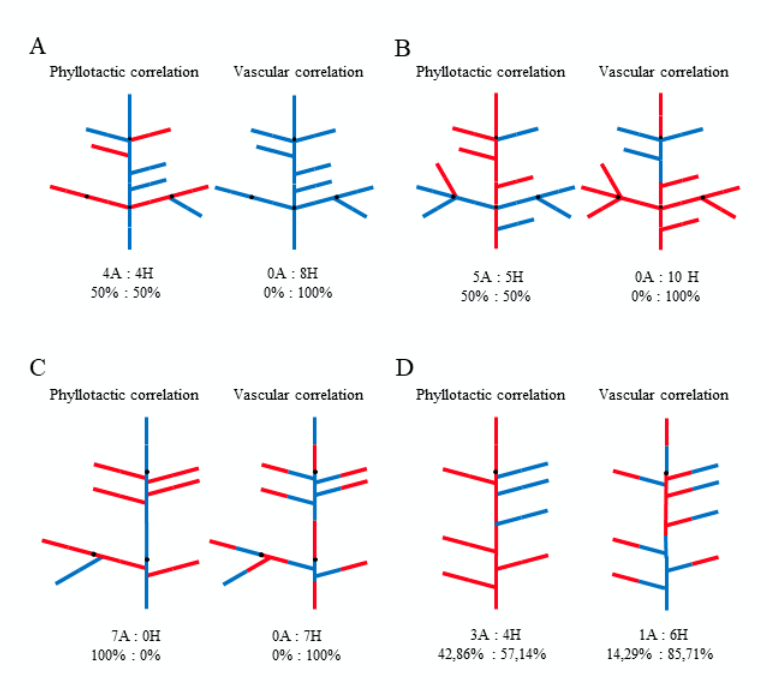
Figure 4 Paired schemes of phyllotactic and vascular correlations in the same branching shoot of Picea abies ( A ), Abies alba ( B ), and Cedrus libani subsp. atlantica ( C,D ). The orientation of ontogenetic helix (the chirality of phyllotaxis) and vascular parastichies is to the left (blue) or to the right (red). Black dot marks the border between two consecutive annual growth increments. Number and percentage of homodromous (H) and antidromous (A) correlations are given below each scheme. In ( A ), phyllotactic correlations (left scheme) suggest random selection of the lateral shoot chirality; vascular correlations (right scheme) show that orientation of vascular sympodia is uniform: to the left in the main axis and the same in all branches of this shoot. Also in ( B ), phyllotactic correlations suggest random selection of the lateral shoot chirality, whereas vascular correlations show that orientation of vascular sympodia is uniform in each branching unit: in the main axis initially to the right and the same in all branches; reorientation of vascular sympodia in the main axis to the left is followed by the same orientation of vascular system in the three subsequent laterals. In ( C ), phyllotactic antidromous correlations suggest nonrandom selection of the lateral shoot chirality; vascular correlations show that orientation of vascular sympodia in the laterals is adapting to ever changing situation in the main axis in order to maintain homodromic correlation. ( D ) is the shoot, in which branching took place also in the lower part of annual increment; phyllotactic correlations suggest random selection of the lateral shoot chirality; vascular correlations show that with only one exception, orientation of vascular sympodia in the laterals is adapting to changing situation in the main axis in order to maintain homodromic correlation.